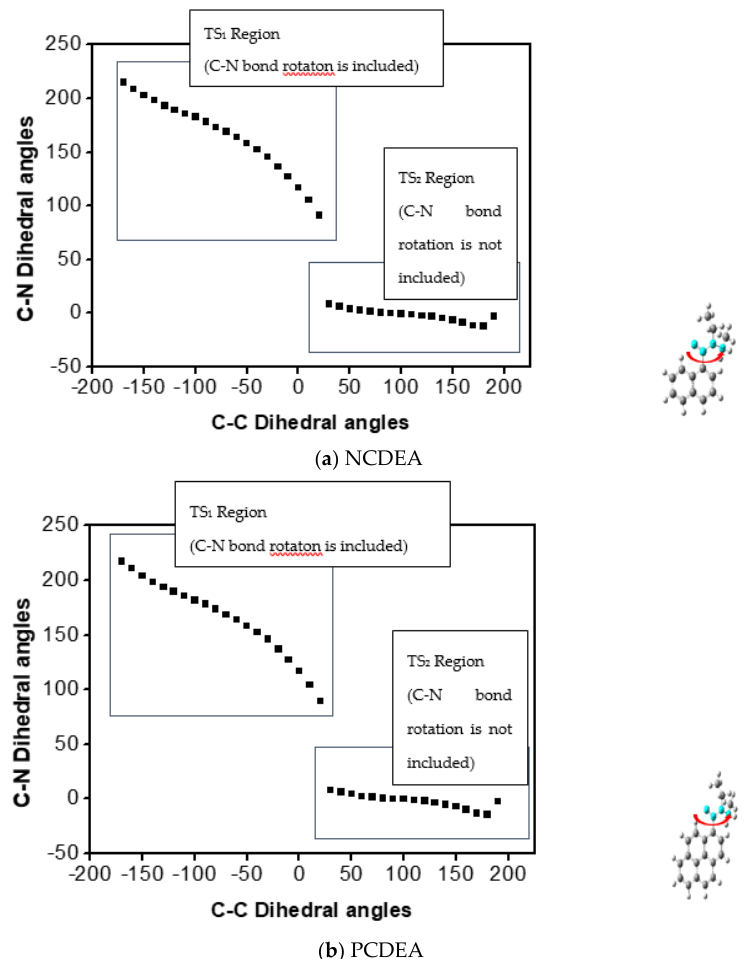
Figure 3. Dihedral angle of C-N bond (highlighted) (Y axis) versus dihedral angle of Aryl-CO bond (Arrowed) (X axis) in ( a ) NCDEA and ( b ) PCDEA.